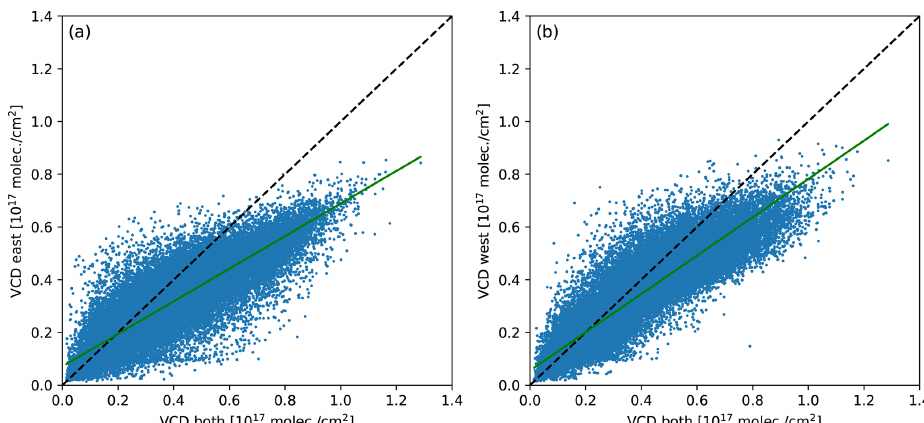
Figure 7. Correlation plots between HCHO VCDs retrieved using dSCDs measured towards the (a) east and (b) west with respect to VCDs retrieved using information from both sides ( x axis). The green lines indicate the linear regression fits, and the black lines represent the 1 : 1 relation.